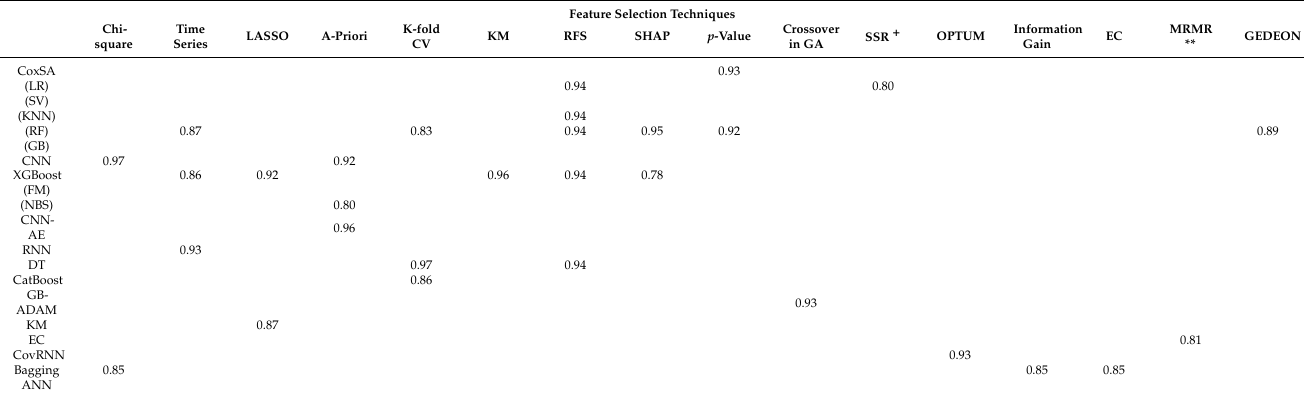
Table 7. Algorithm performance average based on feature selection technique.